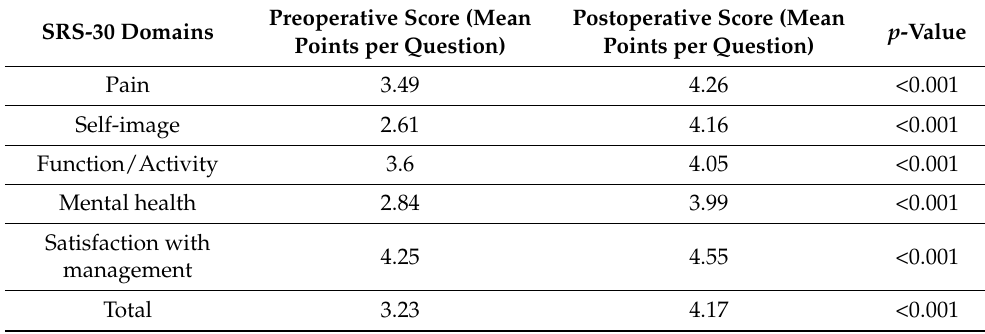
Table 3. Comparison between preoperative and postoperative SRS-30 scores, using the Pearson Correlation coefficient test with p value <